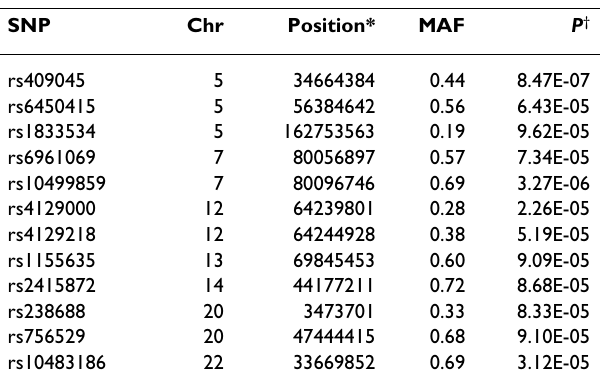
Table 2: SNPs from the genome-wide scan with Q values < 0.8 (i.e., false-discovery rate < 80%). SNP Chr Position* MAF P